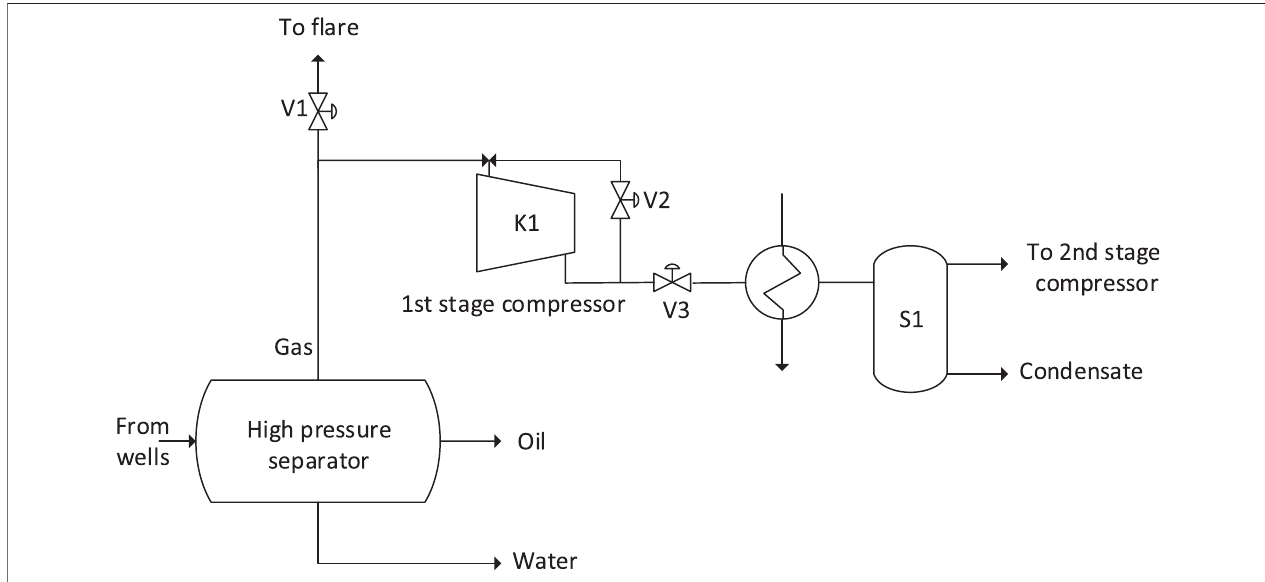
FIGURE 5 | Schematic of the fi rst stage gas compression process. K1 is the compressor, S1 the gas scrubber, V2 the recycle valve, which is normally closed.